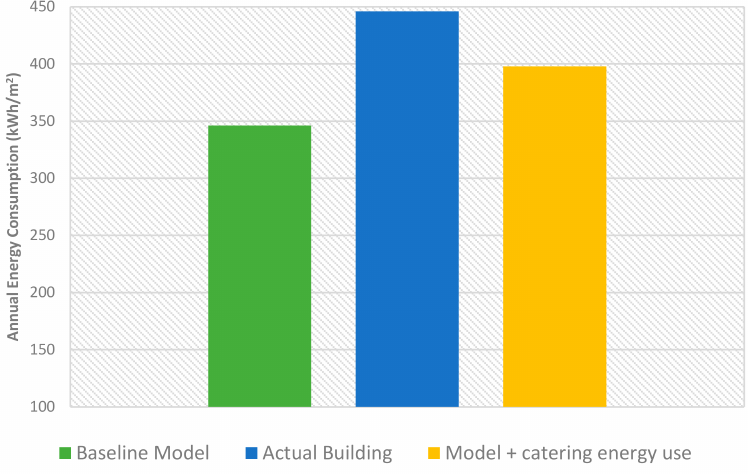
Figure 3. Annual energy consumption of TAS baseline model against actual building